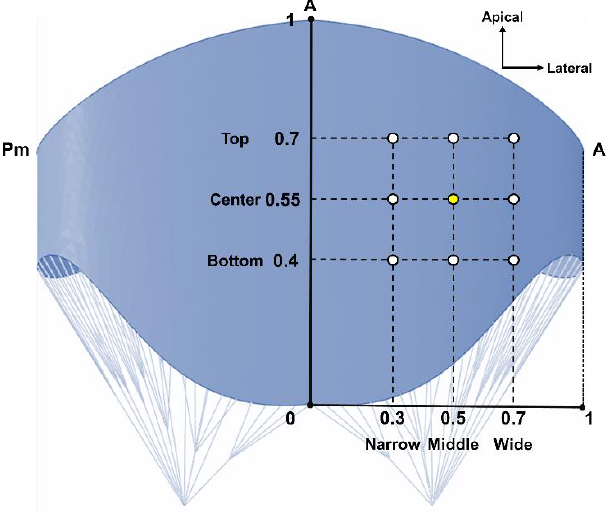
Figure 2. A schematic of anatomical alteration of the SC insertion location (anterior viewpoint). The yellow point indicates the normal SC insertion location. A — anterior; Al — anterolateral; Pm — posteromedial.